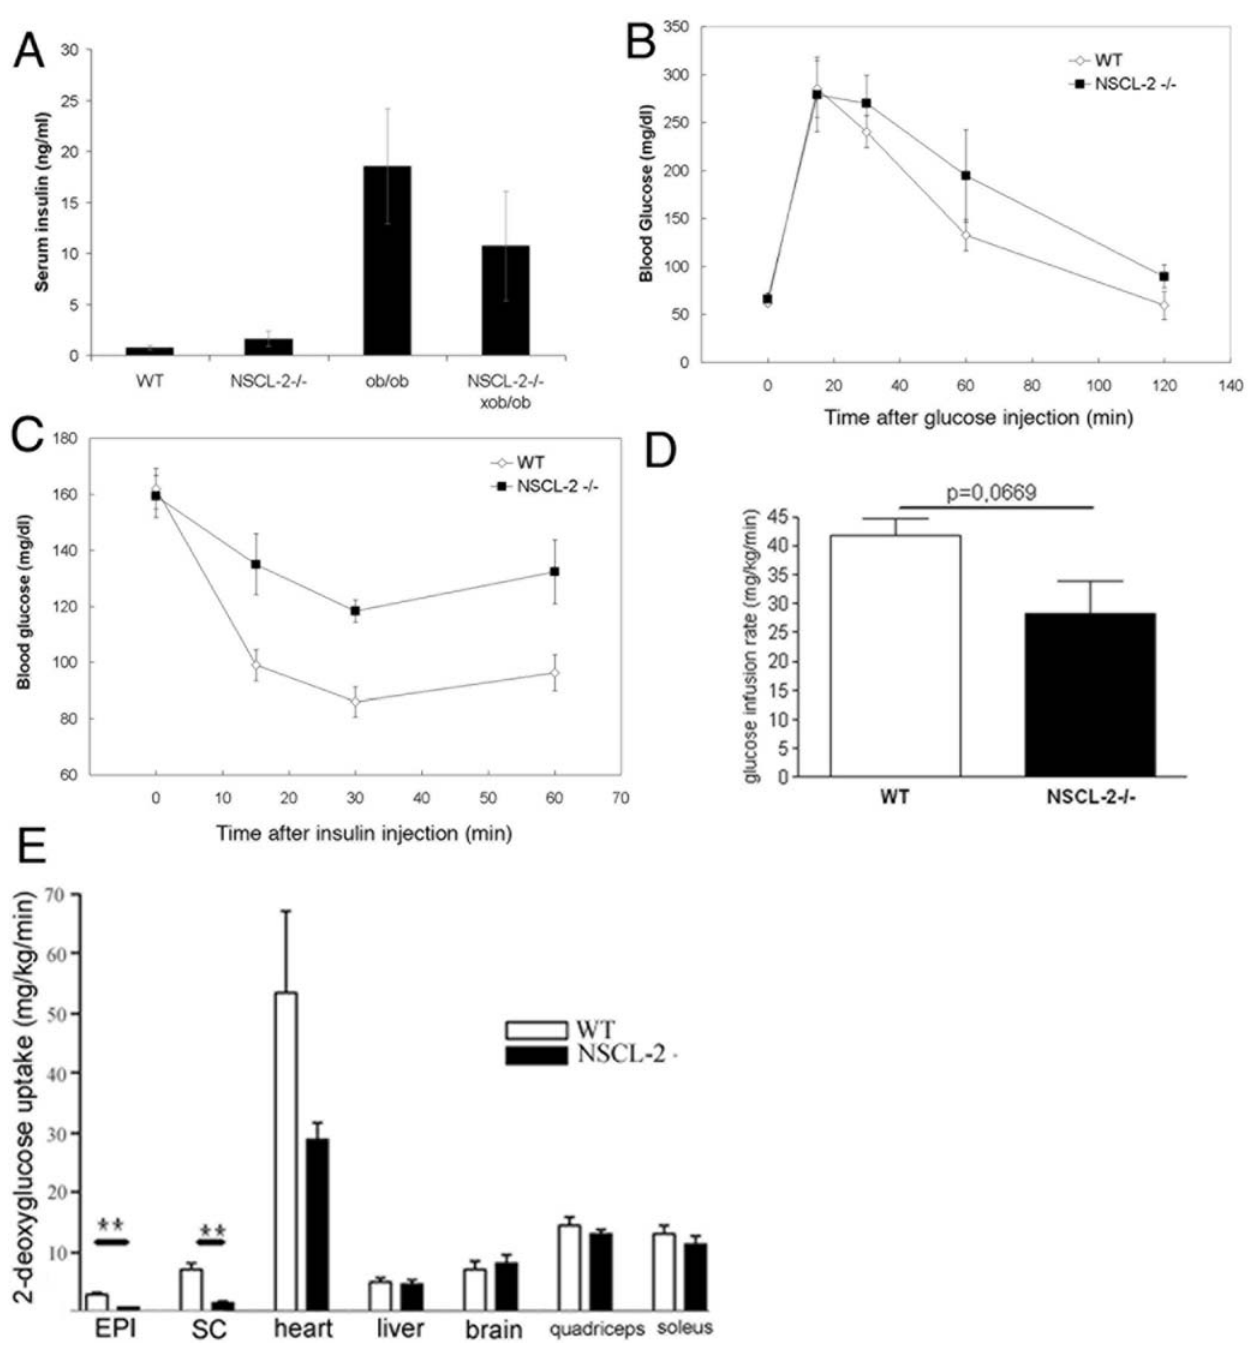
Figure 8. Metabolic parameters and insulin sensitivity in Nscl-2 2 / 2 and WT mice during hyperinsulinemic euglycemic clamp. (A) Ad libitum serum insulin level measured at 9 am in WT controls (n=8), ob/ob mice (n=12), Nscl-2 mutants (n=3) and double mutants (n=3). (B) Glucose tolerance test of 6 months old female WT and Nscl-2 ( 2 / 2 ) mice (n=4). (C) Insulin tolerance test. Means at 15, 30 and 60 minutes are significant higher in Nscl-2 mutants compared to WT mice, (at 15 min: p=0.013; at 30 min: p=0.0014; at 60 min: p=0.017). (D) The glucose infusion rate during a hyperinsulinemic-euglycemic clamp was decreased in Nscl-2 knockout mice compared to C57/Bl6 wild-type mice (n=6). (E) Insulin stimulated 2- deoxyglucose uptake in vivo in different tissues during the clamp. Nscl-2 2 / 2 mice show specific insulin resistance in WAT (EPI: 70% reduction (p=0.003); SC: 79% reduction (p=0.010).